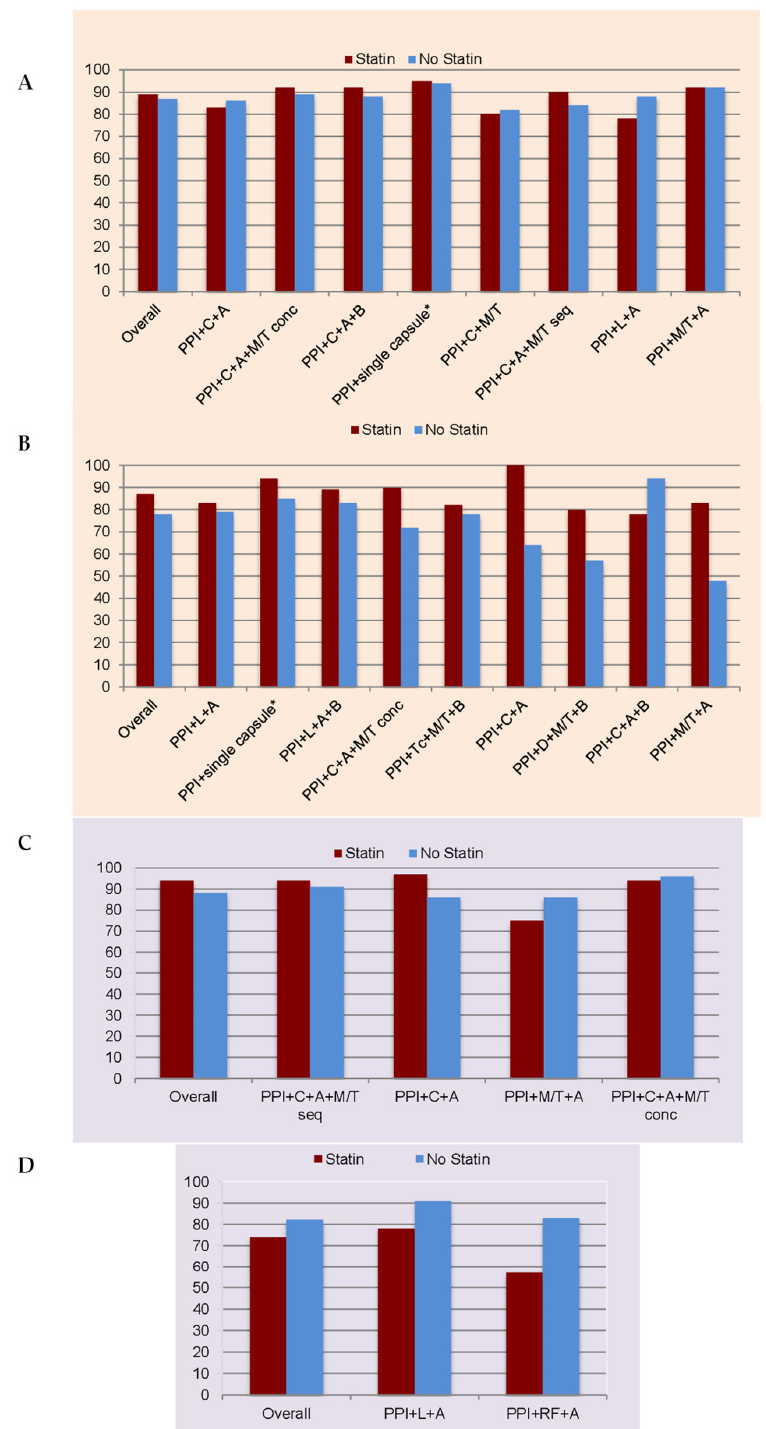
Figure 2. mITT effectiveness according to statin-status and receiving each specific therapy. ( A ) Em- pirical approach: first-line. ( B ) Empirical approach: rescue lines. ( C ) Culture-guided approach: first-line. ( D ) Culture-guided approach: rescue lines. PPI = proton pump inhibitor. C = clarithromycin. A = amoxicillin. M = metronidazole. T = tinidazole. B = bismuth. Single-capsule * = three-in-one single capsule containing bismuth, tetracycline and metronidazole. L = levofloxacin. Tc = tetracycline. D = doxycycline. RF = rifabutine. Conc = concomitant administration. Seq = sequential